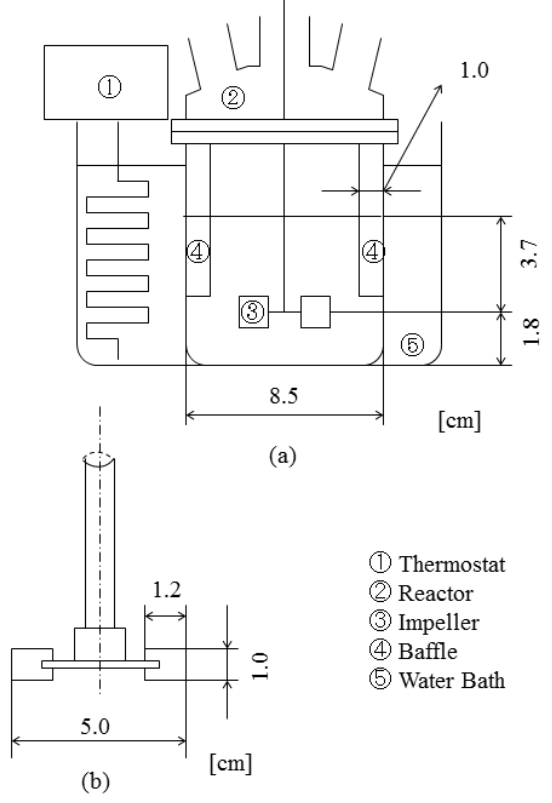
Figure 2. Schematic diagrams of experimental